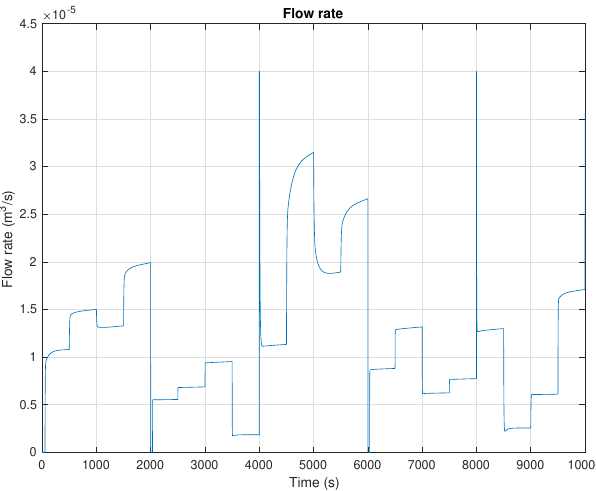
Figure 25. Flow rate profile during the simulation.